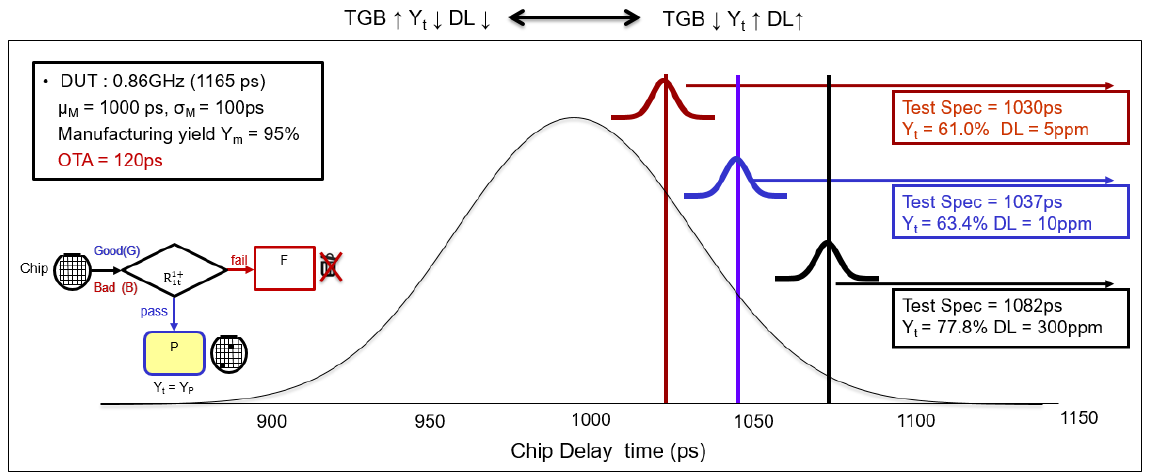
Figure 3. Influence of test guardband on test yield and test quality.